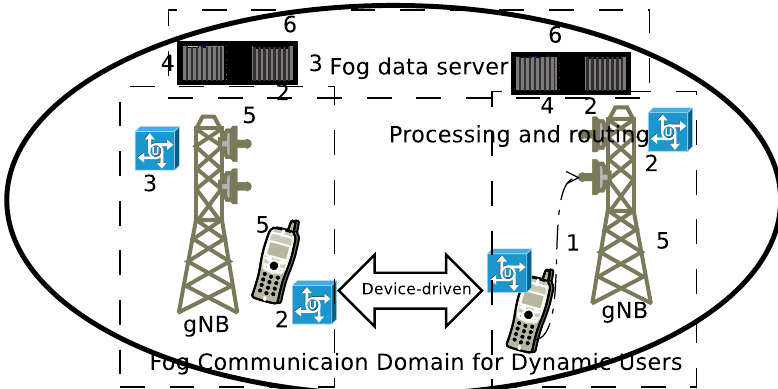
Figure 4. Fog network’s communication methodology for dynamic mobile users. Mobile nodes are using device-driven communication.